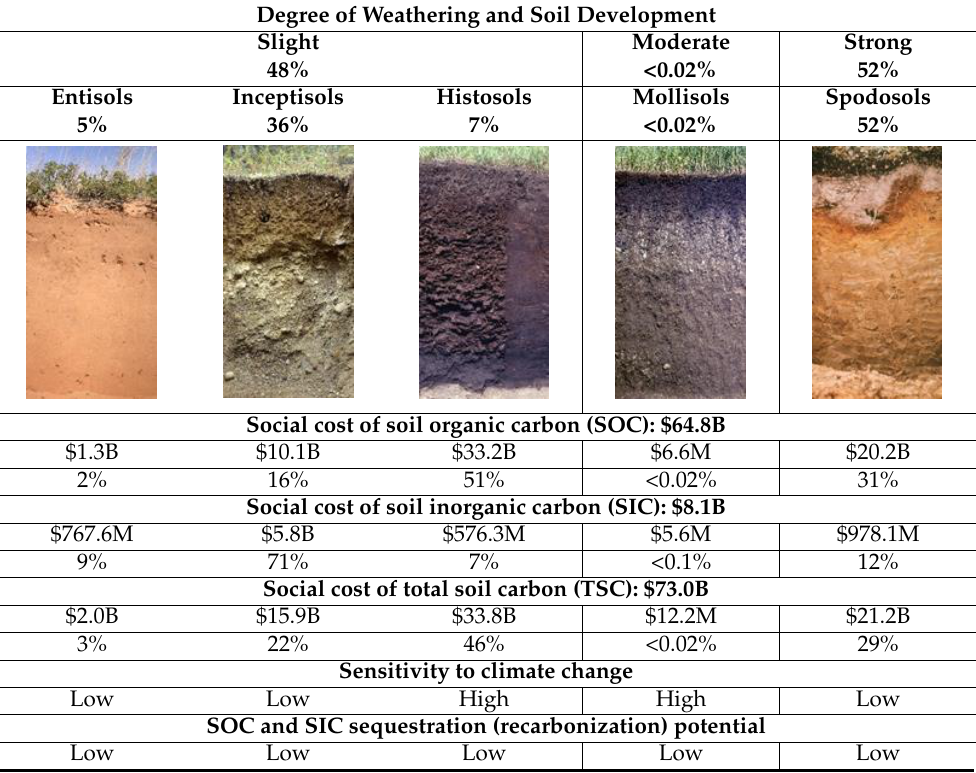
Note: Entisols, Inceptisols, Mollisols, and Spodosols are mineral soils. Histosols are mostly organic soils. M = million = 10 6 ; B = billion = 10 9 .